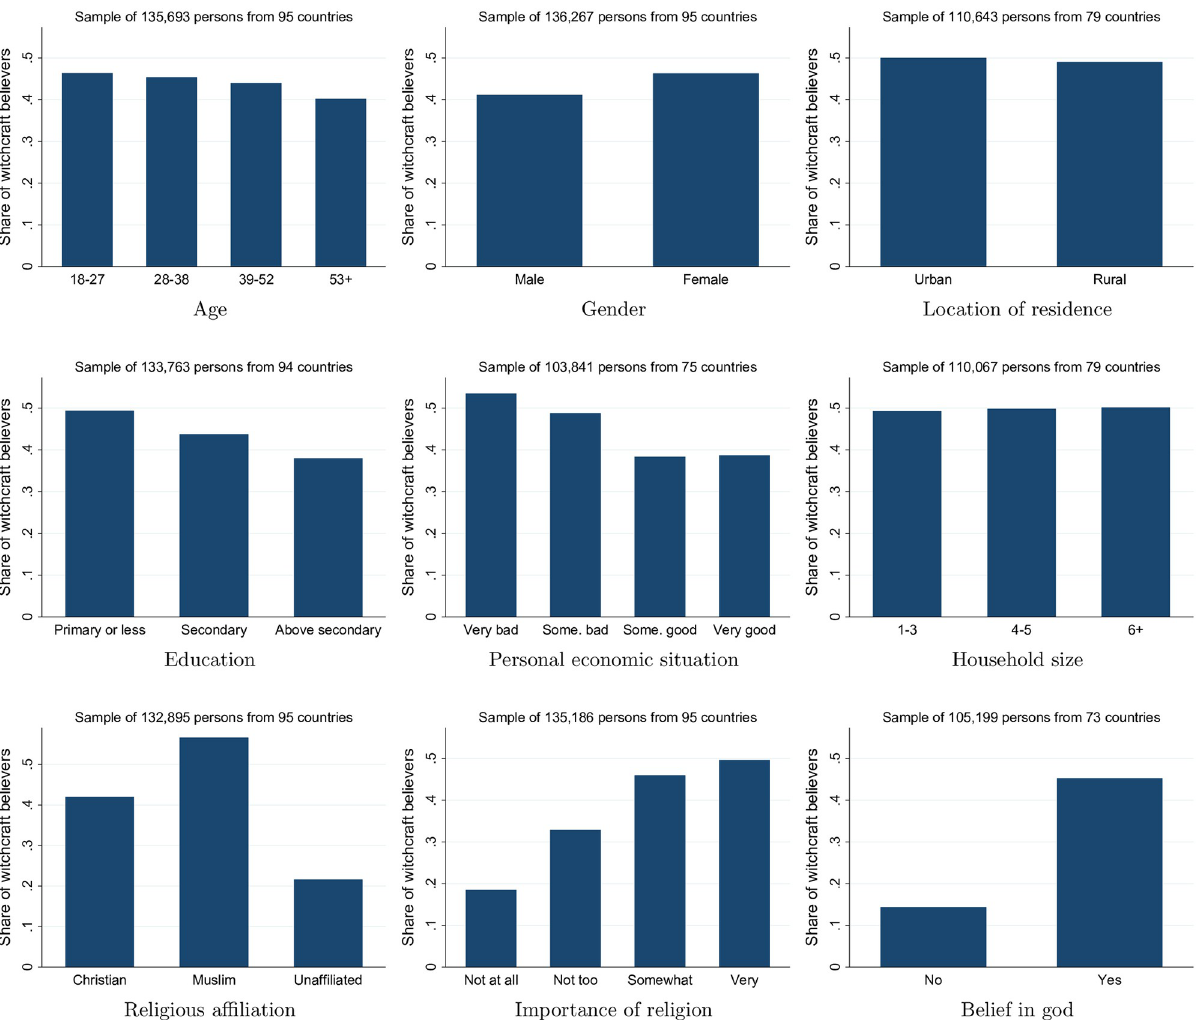
Fig 2. Socio-demographic correlates of witchcraft beliefs. In the sample underlying the religious affiliation panel, about 62% and 27% of respondents identify themselves as Christian and Muslim, respectively, while slightly over 10% are “unaffiliated.” Overall, 95% of witchcraft believers consider themselves either Christian or